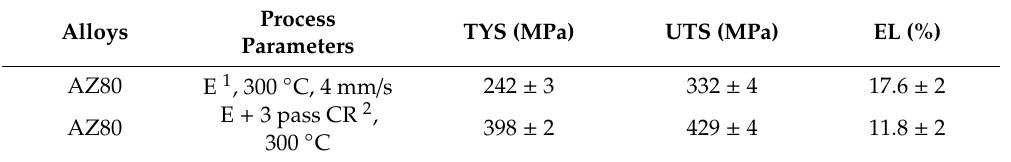
Table 2. Mechanical performance of CRed Mg alloys compared with corresponding as-extruded sample